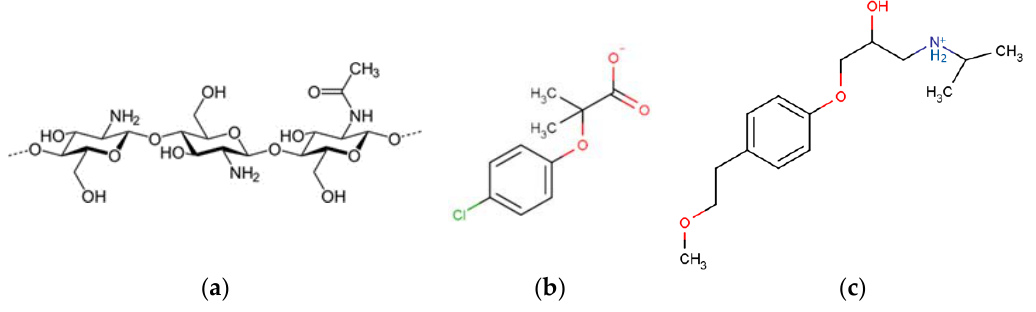
Figure 1. Molecular structures and speciation of chitosan (CS) ( a ); clofibric acid (CBA) ( b ); and metoprolol (MTP) ( c ) at pH 6.5. Table 1. Physicochemical characteristics of the adsorbates at pH 7.